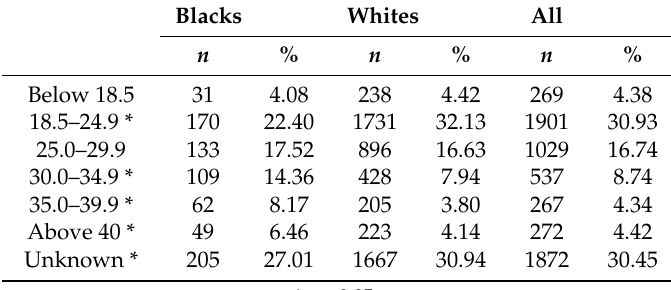
Table 2. Body mass index characteristics for Blacks ( n = 759) and Whites ( n = 5388) with suicidal attempt. Blacks